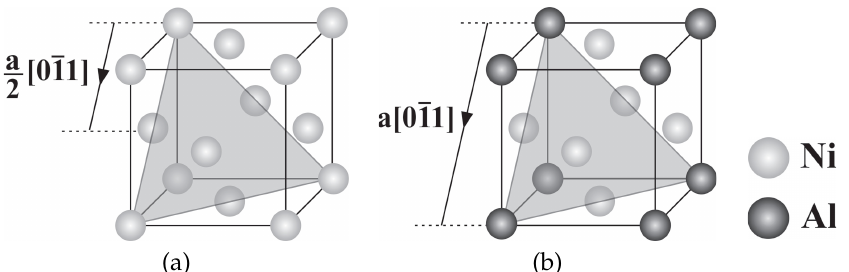
Figure 2. Dislocations in two-phase nickel-based superalloys: ( a ) Crystalline structure of γ phase and ( b ) Crystalline structure of γ (cid:48) phase.